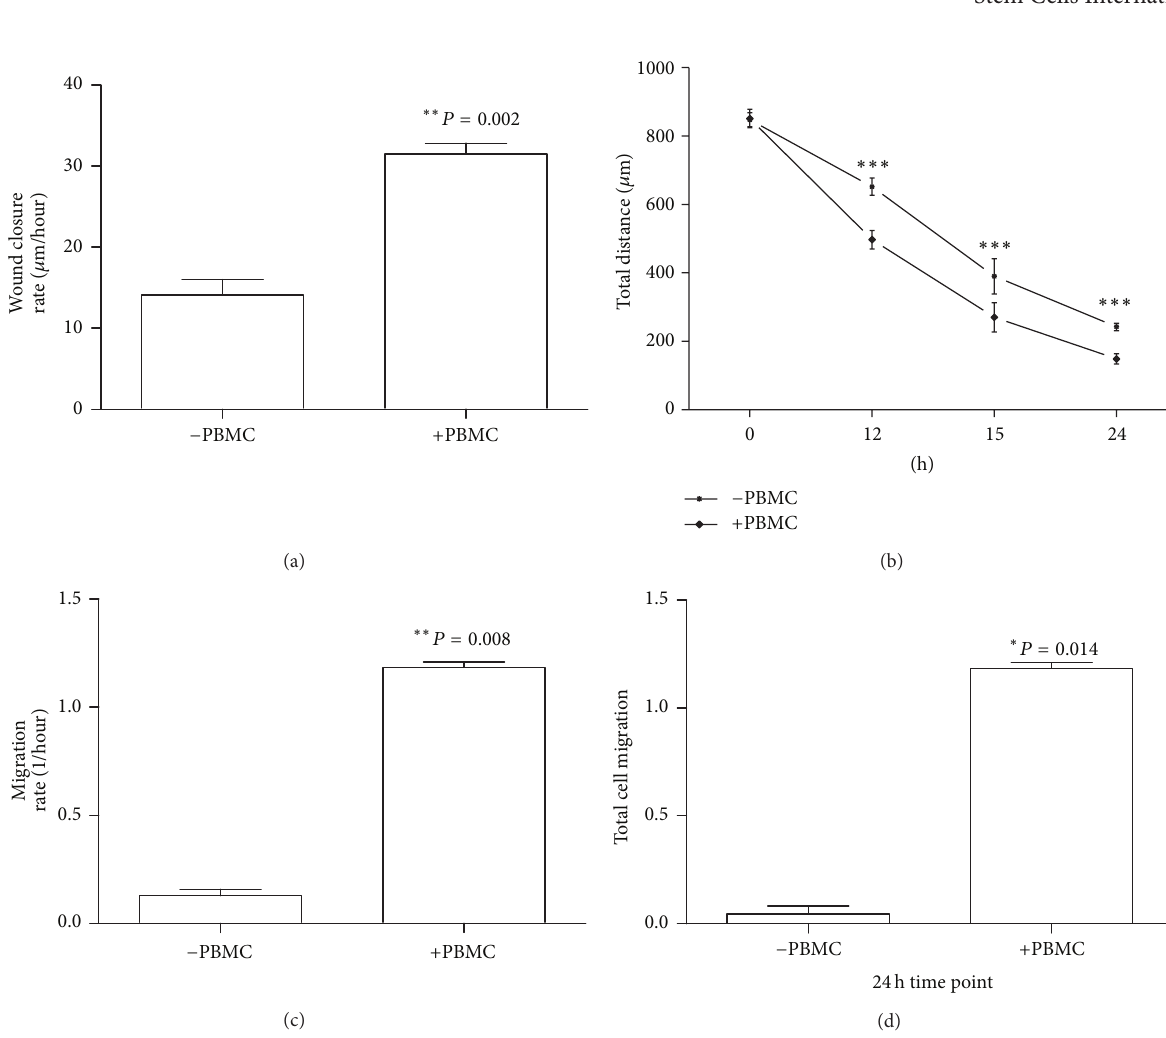
Figure 2: Cell migration experiment of MSCs measured over 24 hours comparing the effect of PBMC stimulus ( 𝑛 = 4 ). (a) Wound closure rate measured at 3-hour time point ( 𝑛 = 4 ) in the scratch assay with direct cell-to-cell contact. (b) The total distance of the wound measured at 12-, 15-, and 24-hour time points is not to scale ( 𝑛 = 4 , 𝑃 < 0.0001 ) in the scratch assay. (c) The initial cell migration rate at 3-hour time point quantified real time with the xCELLigence system and (d) the total amount of cells migrated at the 24-hour time point quantified with cell index value by